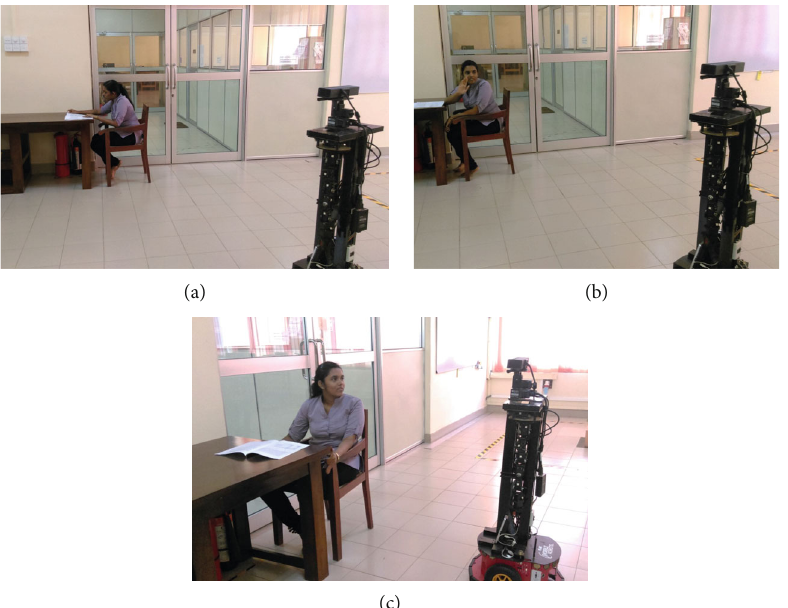
Figure 2: An application of the two theories: occasion 1 (a), user was working and has no idea about the presence of the robot, (b) notices the presence of the robot as it moves and as a result, the user looks at the robot, and (c) stops the work and gives attention to the robot while it approaches the user.